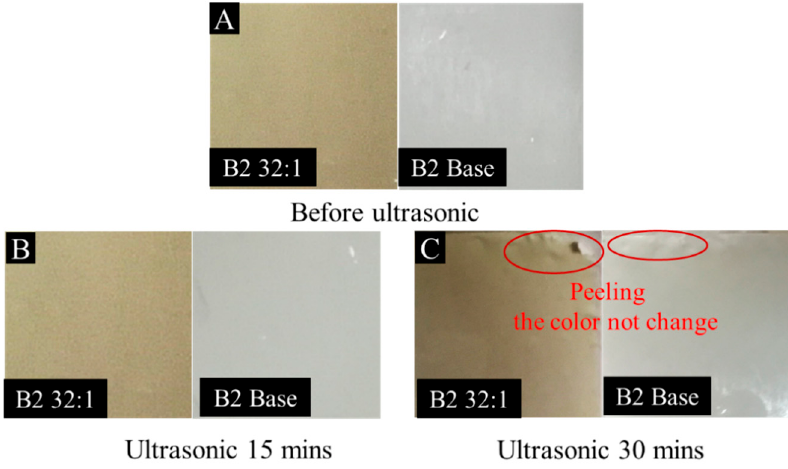
Figure 6. Digital photographs of B2 Base and B2 32:1 membrane before ( A ) and after ultrasound ( B : ultrasound 15 mins; C : ultrasound 30 mins). ultrasound 15 mins; C : ultrasound 30